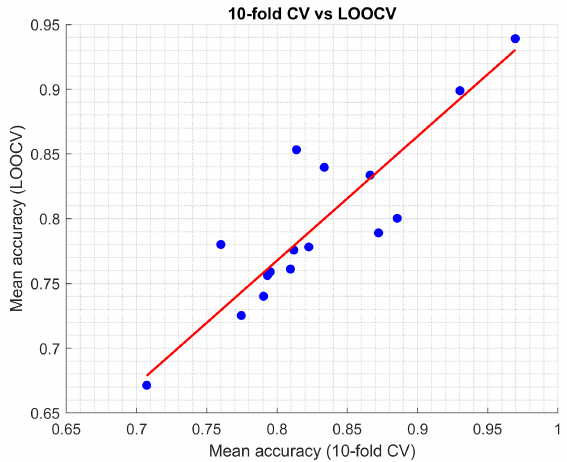
Figure 14. The cross-validation graph of accuracy distribution: 10-fold cross-validation vs. LOOCV.